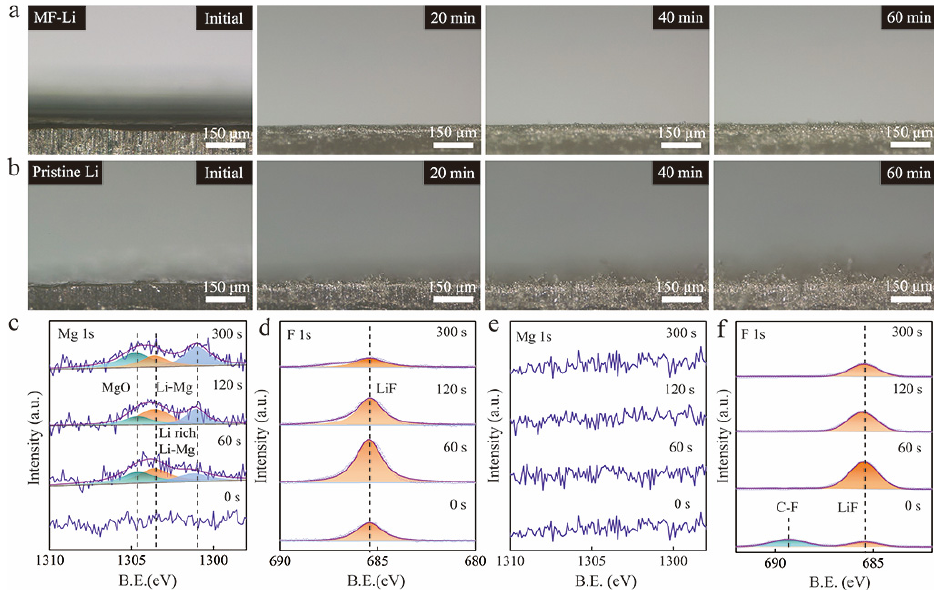
Figure 3. In situ optical microscopy visualization for the Li||Li cells with ( a ) the MF-Li anode and ( b ) the pristine Li anode. The scale bars are 150 μ m. XPS depth analysis of the modified layer on MF-Li and pristine Li anodes after 5 cycles in the Li||Li cells: ( c ) Mg 1s and ( d ) F 1s spectra of the MF-Li anode; and ( e ) Mg 1s and ( f ) F 1s spectra of the pristine Li anode after different etching duration (depths).